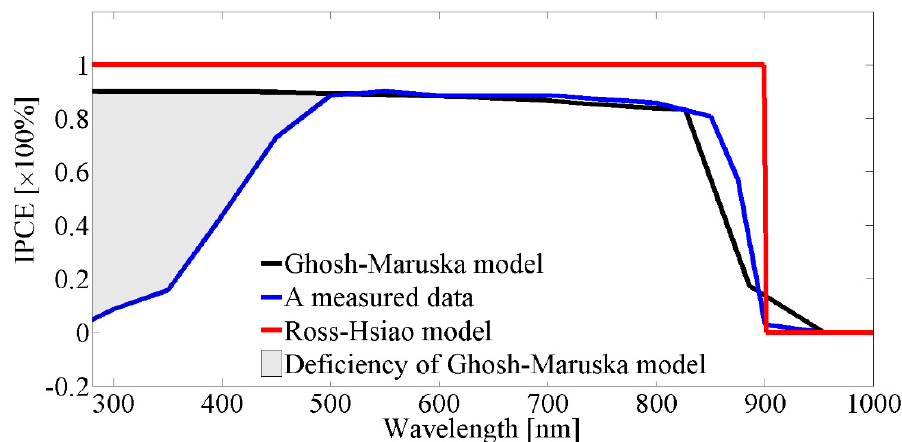
Figure 3. Incident photon-to-current conversion efficiency (IPCE) curves according to models and measured data at GaAs photo-electrode.